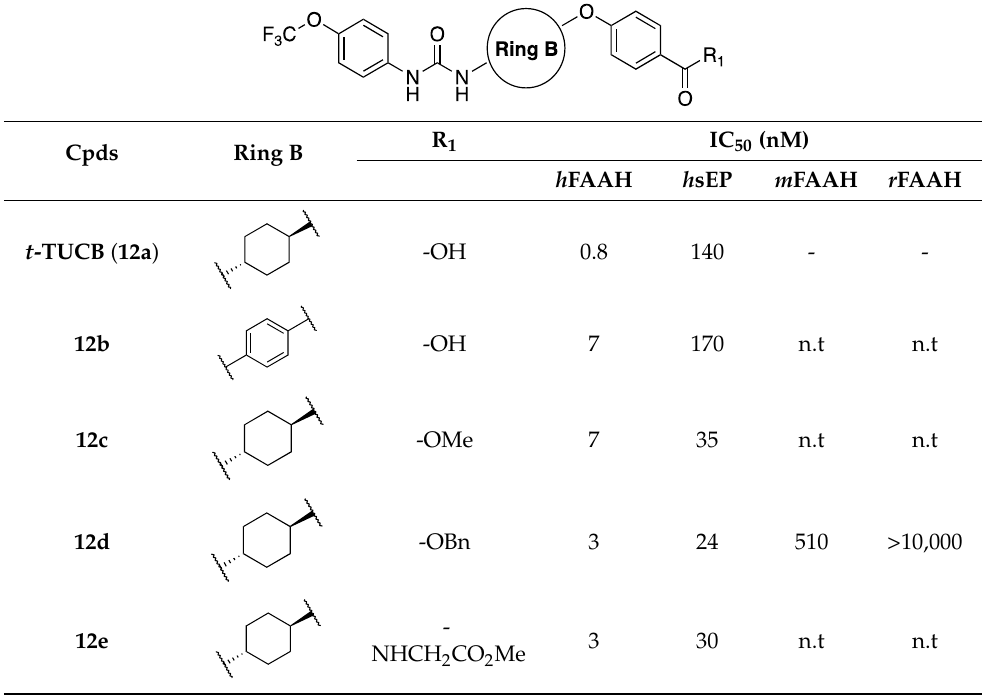
Table 6. FAAH and sEH activities of t -TUCB derivatives.